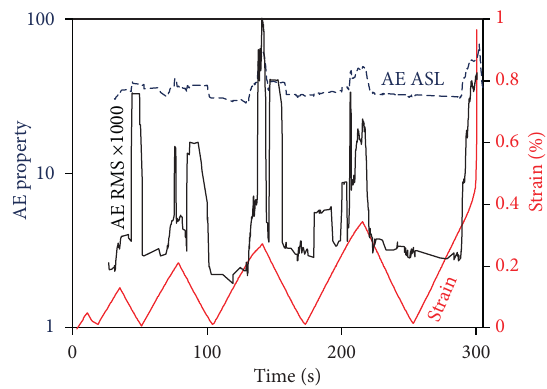
Figure 11: Strain history and AE amplitude parameters for a double- edge notched specimen with notch-to-width ratio of 0.35.